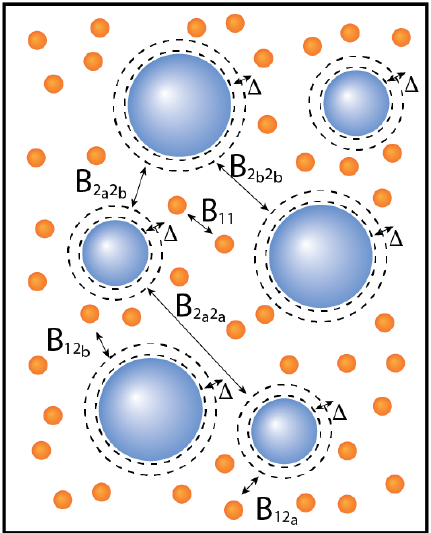
Figure 1. Graphical representation of a simple polydisperse mixture, in which the polydisperse component consists of two subcomponents ( a and b , n = 3); second virial coefficients are indicated. The distance of closest approach is influenced by ∆ : ∆ > 0 increases this distance, ∆ < 0 decreases this